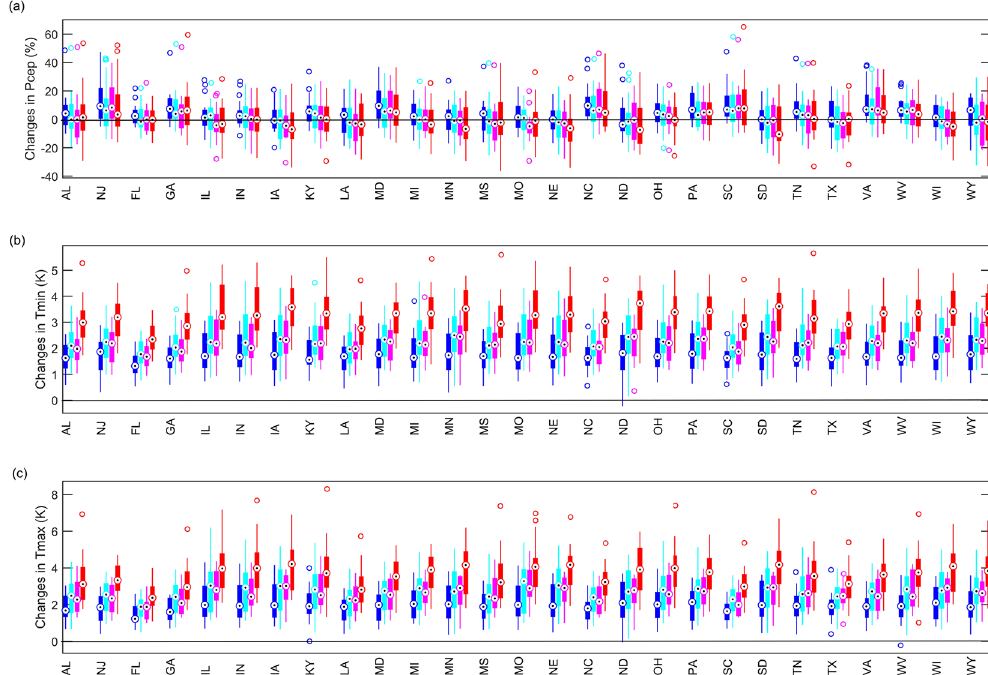
Figure 3. Projected changes in ( a ) precipitation (Prec), ( b ) daily minimum temperature (Tmin), and ( c ) daily minimum temperature (Tmax) by 2050 s relative to 1970–1999. 97 bias-corrected climate projections under four RCPs are used to characterize the uncertainty from climate models and emission scenarios. Only states where the constructed empirical models are significant at the 95% confidence level are included for analysis. Figure was created using software MATLAB 2015a